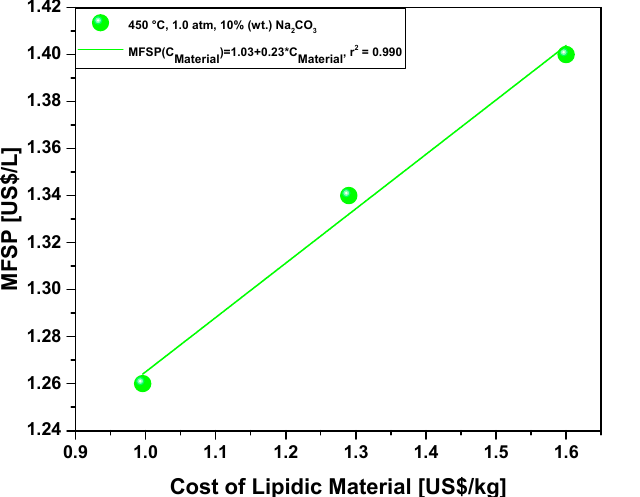
MFSP is reduced to 1.05 US$/L (which is a value extremely near to that applied in Brazil to biofuels). Figure 6. MFSP as a function of distillation yield by sensitivity analysis for a 450 L/day production. Figure 7 is the MFSP as a function of the cost of lipidic material by sensitivity analysis